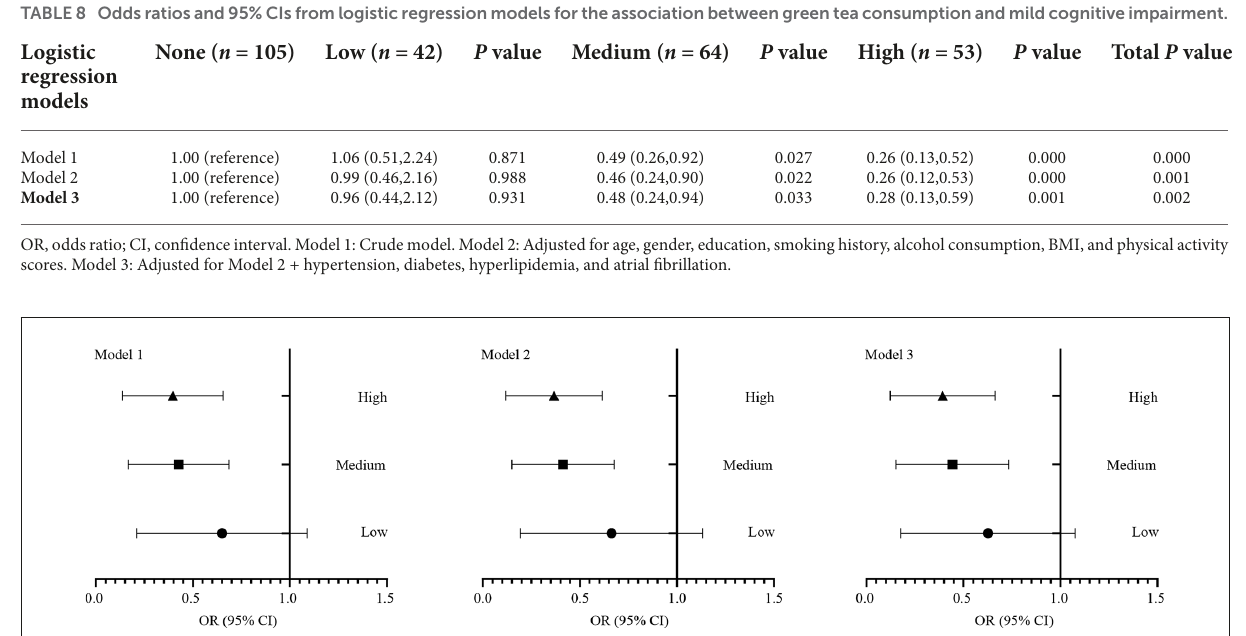
FIGURE7 The logistic regression analysis between green tea consuming and cognitive impairment. All 264 subjects were divided again into the MCI group (MoCA < 24 scores) and the control group (MoCA ≥ 24 scores). Statistically, significant inverse associations were observed between green tea consuming and mild cognitive impairment. Model 1: Crude model. Model 2: Adjusted for age, gender, education, smoking history, alcohol consuming, BMI, and physical activity scores. Model 3: Adjusted for Model 2 + hypertension, diabetes, hyperlipidemia, and atrial fibrillation. OR, odds ratio; CI, confidence